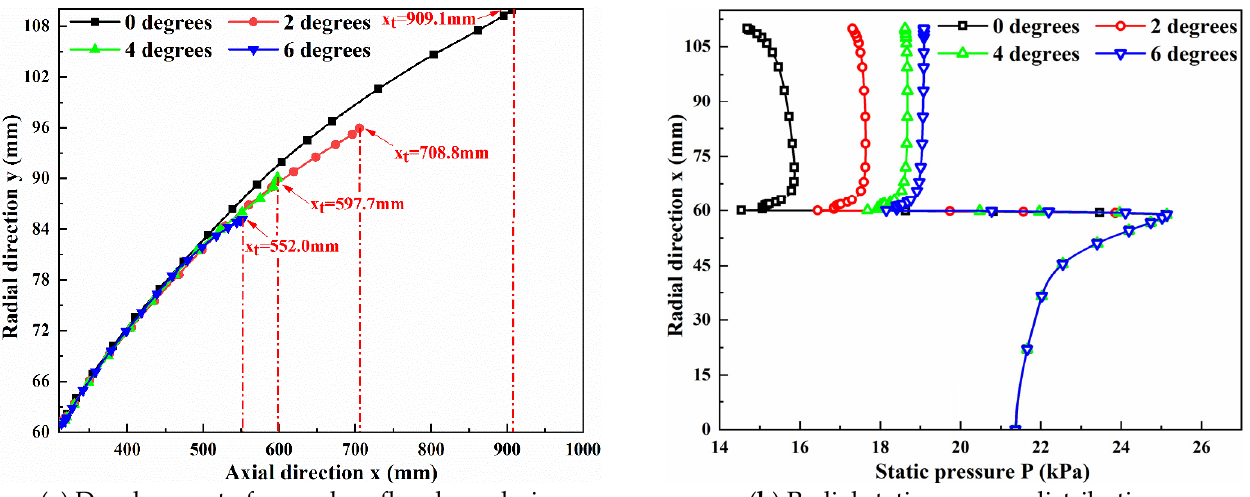
Figure 8. Contraction angle ( φ ) at different mixing chambers: ( a ) development of the secondary flow boundary from the nozzle exit to the wall of the mixing chamber; ( b ) Static pressure radial distribution in the nozzle exit section (the secondary flow boundary and the wall of the mixing chamber intersect at x t .).